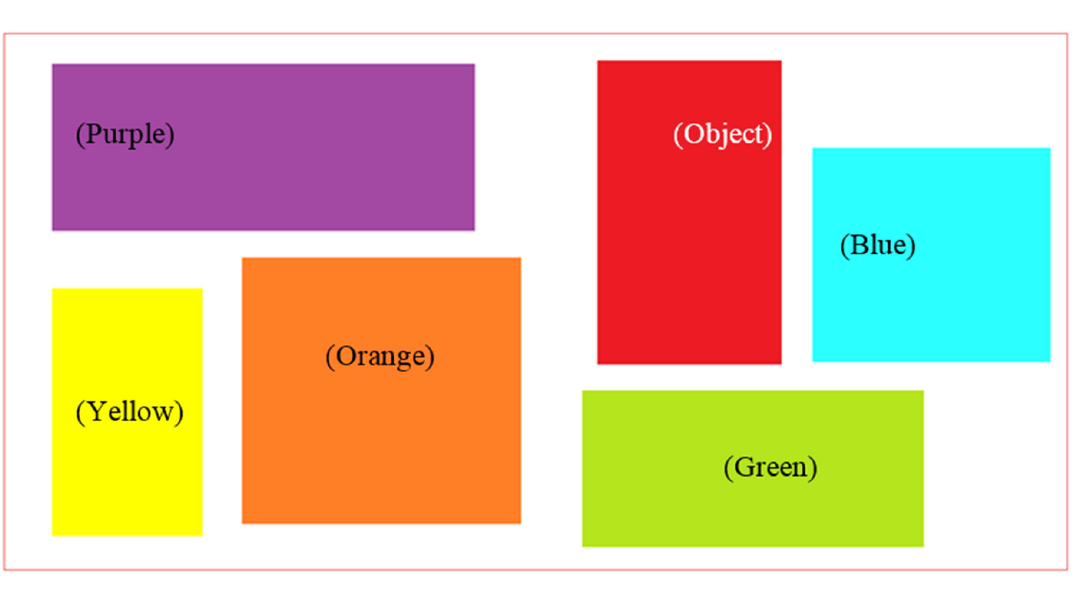
Figure 2. Blocks in different colors. Table 1. The known pattern color values.